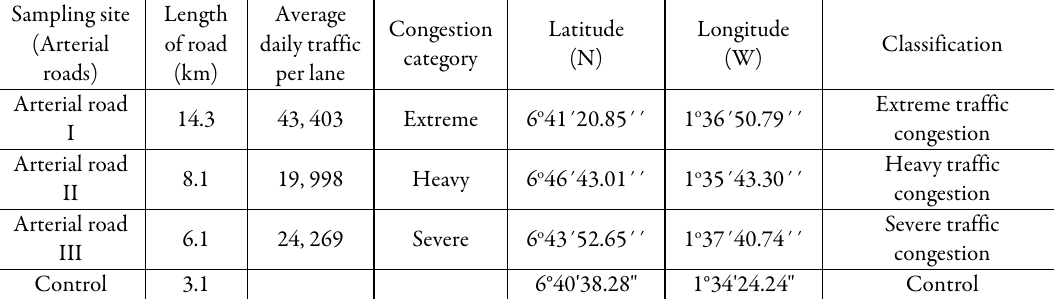
Table 1. Description of sampling sites in Kumasi